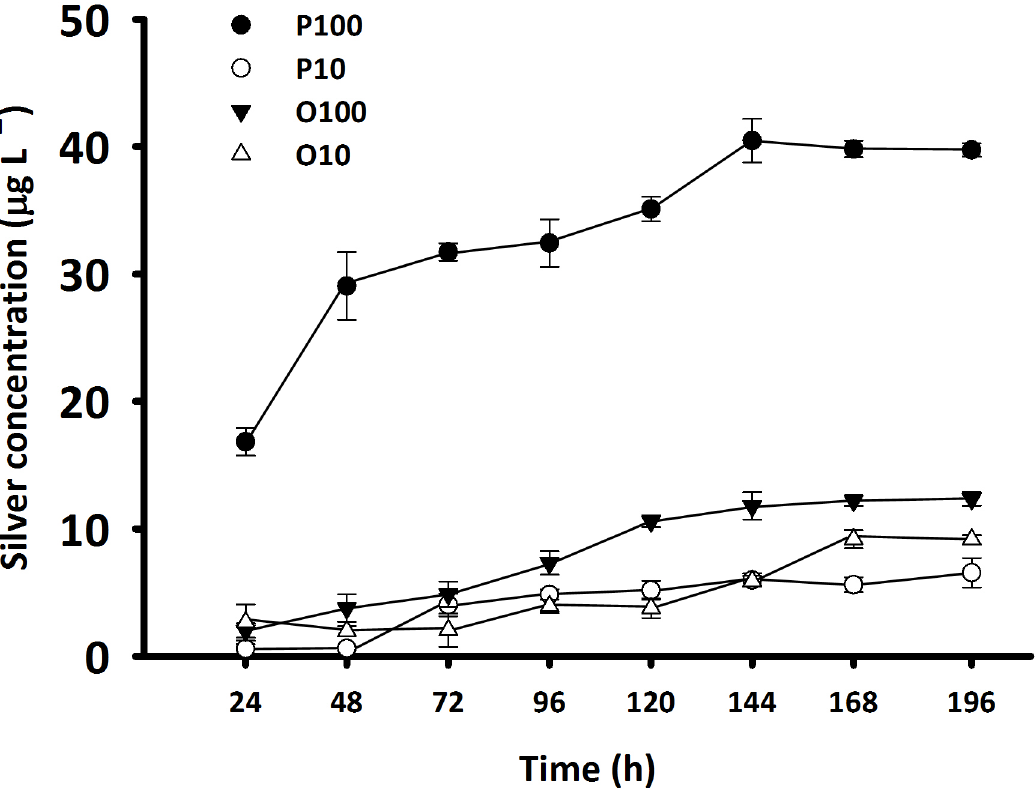
Fig 3. Concentration of silver released from coated AgNPs mixed in filter seawater at 10 and 100 μ g L -1 . OAgNPs at 10 μ g L -1 (O10; open triangle) and 100 μ g L -1 (O100; filled triangle). PAgNPs at 10 μ g L -1 (P10; open circle) and 100 μ g L -1 (P100; filled circle). Samples were collected every 24 h followed by ultracentrifugation for silver measurement using inductively coupled plasma-optical emission spectrometer. Each data point represents the mean ( ± SD) of